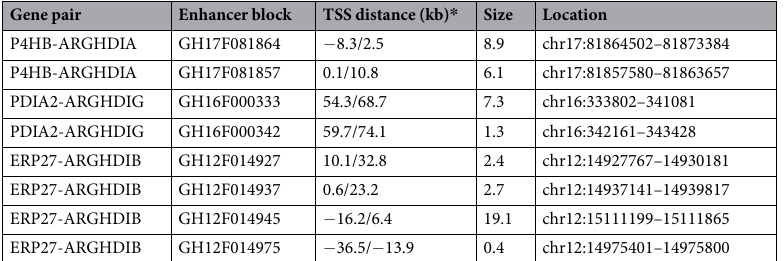
Table 2. In silico analysis of potential enhancer sequence blocks associated with PDI-RhoGDI gene pairs. * Distance of the enhancer element from the transcription start site (TSS) of the PDI or RhoGDI gene, respectively. Negative values indicate a localization upstream of the TSS. Abbreviations: ARGHDIA, RhoGDI α ; ARGHDIB, RhoGDI β ; ARGHDIG, RhoGDI γ ; chr, chromosome; PDIA8, Erp27; P4HB, PDIA1; TFB, Transcription binding site; TSS, transcription start site.